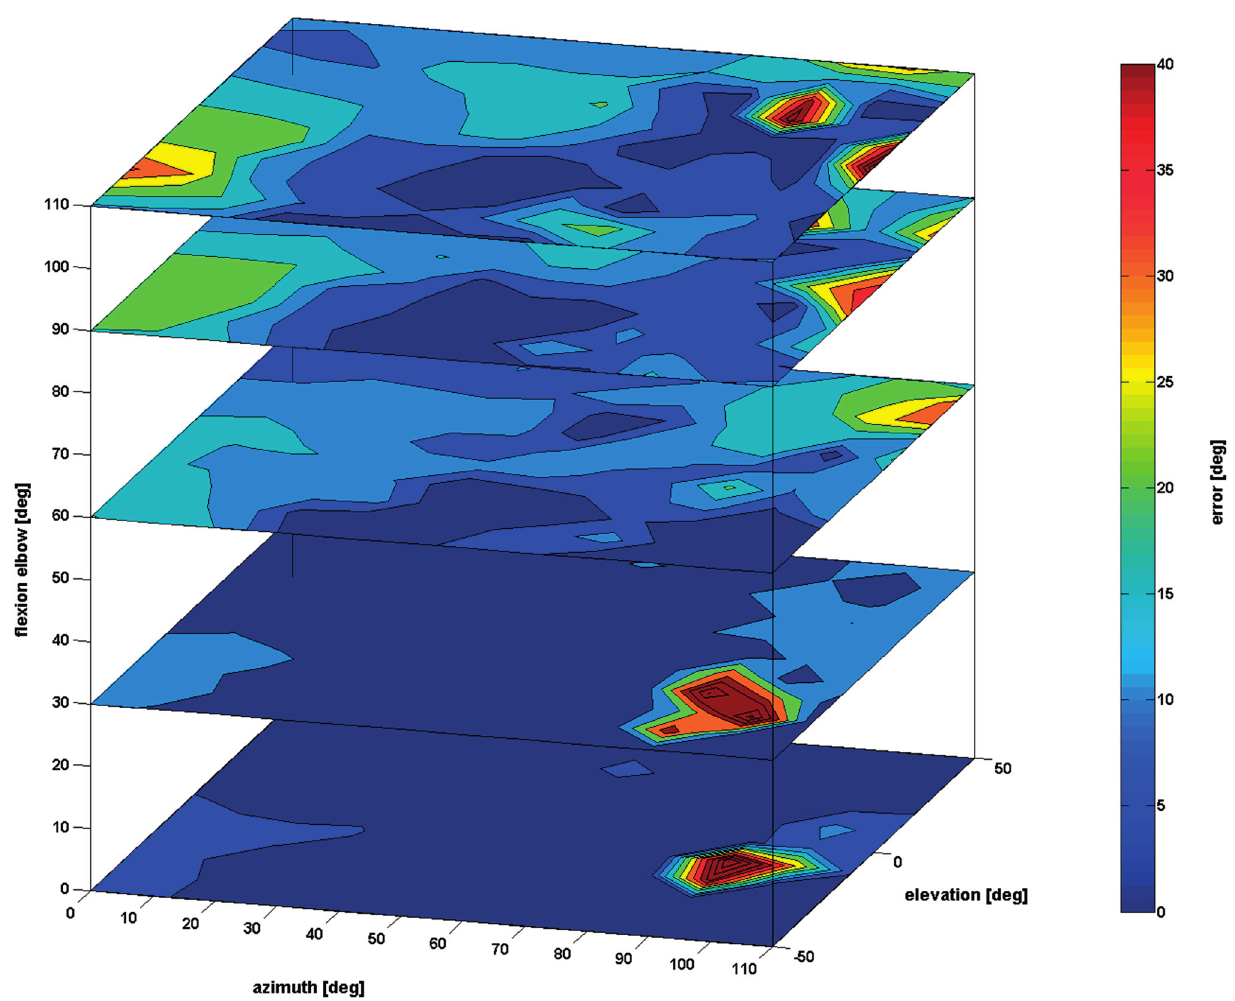
Figure 6. Accuracy of the Kinect measurement of the shoulder angle (0° swivel angle) according to three parameters: azimuth, elevation, and elbow